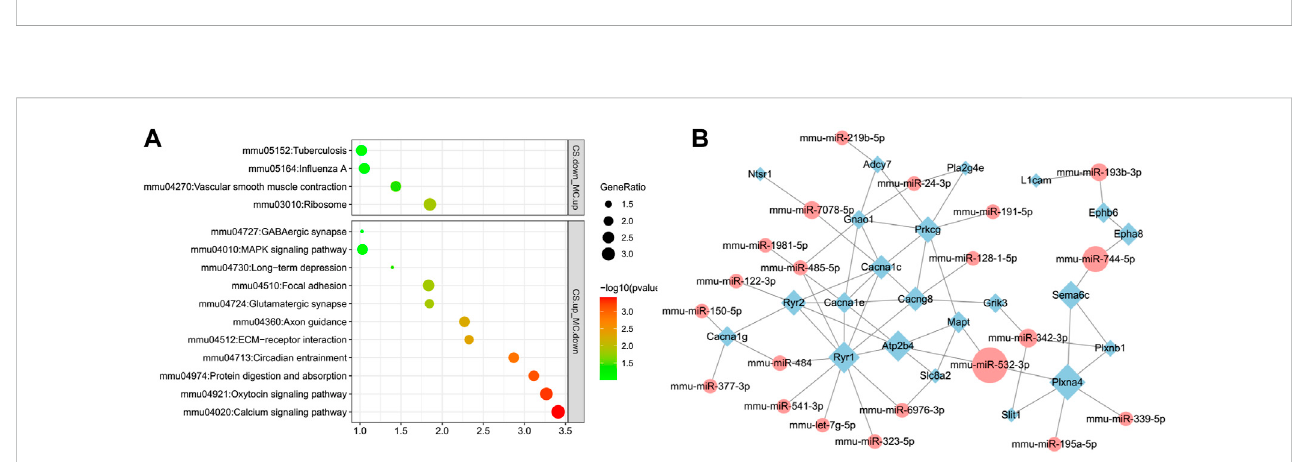
FIGURE 6 InteractionsbetweenmiRNAandmRNAofcocaineaddictionandMETtreatmentresponsetococaineaddiction. (A) Heatmapofallsigni fi cantmiRNAsin each group (saline + cocaine [CS], MET + saline [MS], and MET + cocaine [MC]). Red, upregulated; blue, downregulated. (B,C) Scatter plot of DE-miRNAs depicting expression changes between the MS and CS (B) and between the MC and CS (C) groups.